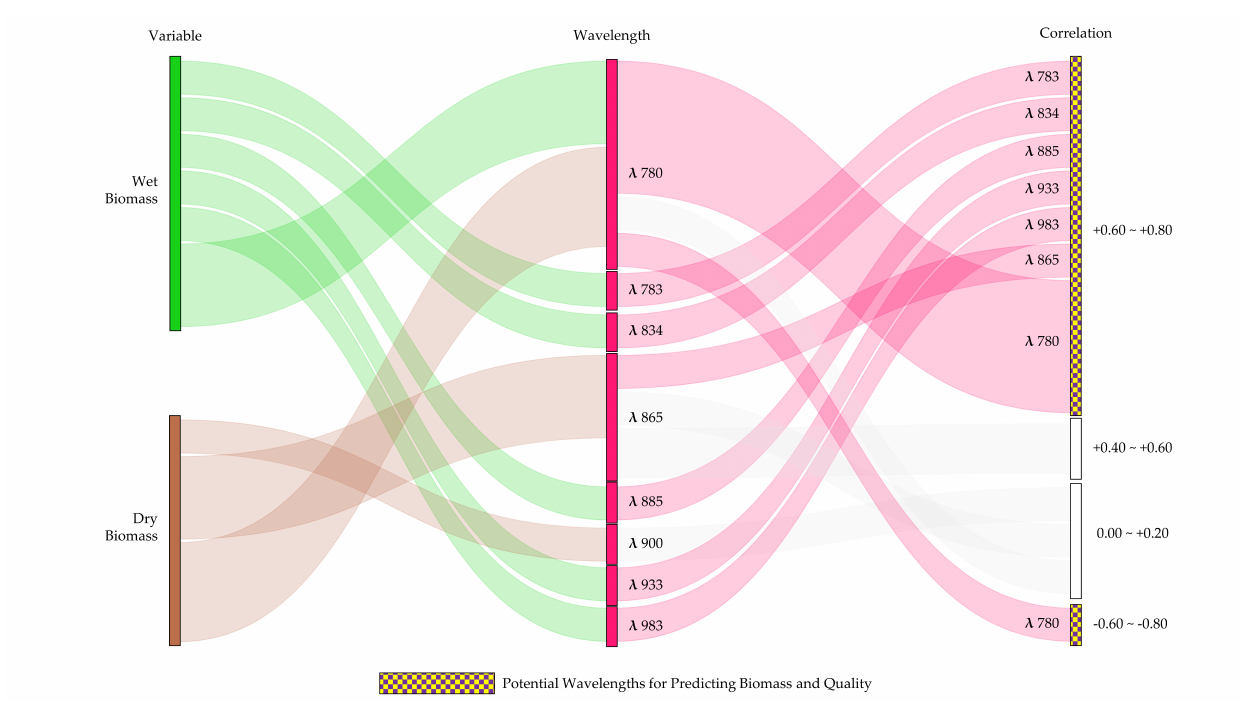
Figure A5. Sankey diagram illustrates the wavelengths in the near-infrared region ( λ 760 − 1000) most correlated with alfalfa biomass and quality traits. The flow chart intuitively displays bars and paths drawn in proportion to the amount of information used. The larger the bars, the more times this information has been used. Colored pathways assign the connections between alfalfa biomass and quality traits and its usage in remote sensing data (i.e., wavelengths or vegetation indices) as well as its response to the strength of the correlation. When wavelength or vegetation indices have the potential to be used to establish a relationship with biomass and quality traits, they are marked. The colors of each correlation bar are linked to the biomass and quality traits. When it is white, it is because it has no potential to be used. However, when the bar is colored and checkered, it indicates that although it has not been used to study its relationship with quality, it has the potential to predict it assuming its correlation with